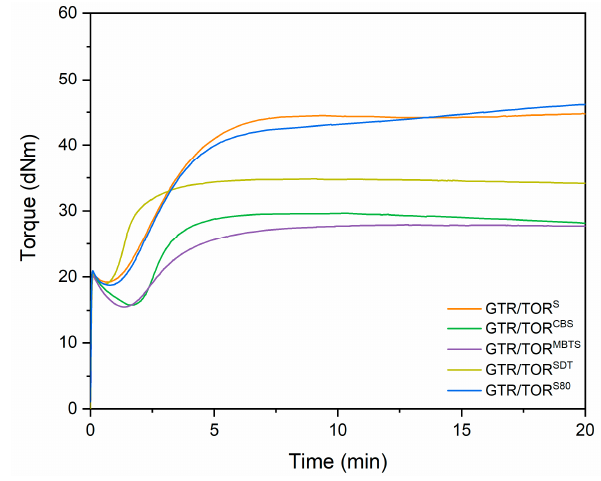
Figure 2. Curing curves of studied samples performed at 180 °C. Table 3. Curing characteristics of studied samples performed at 180 ◦